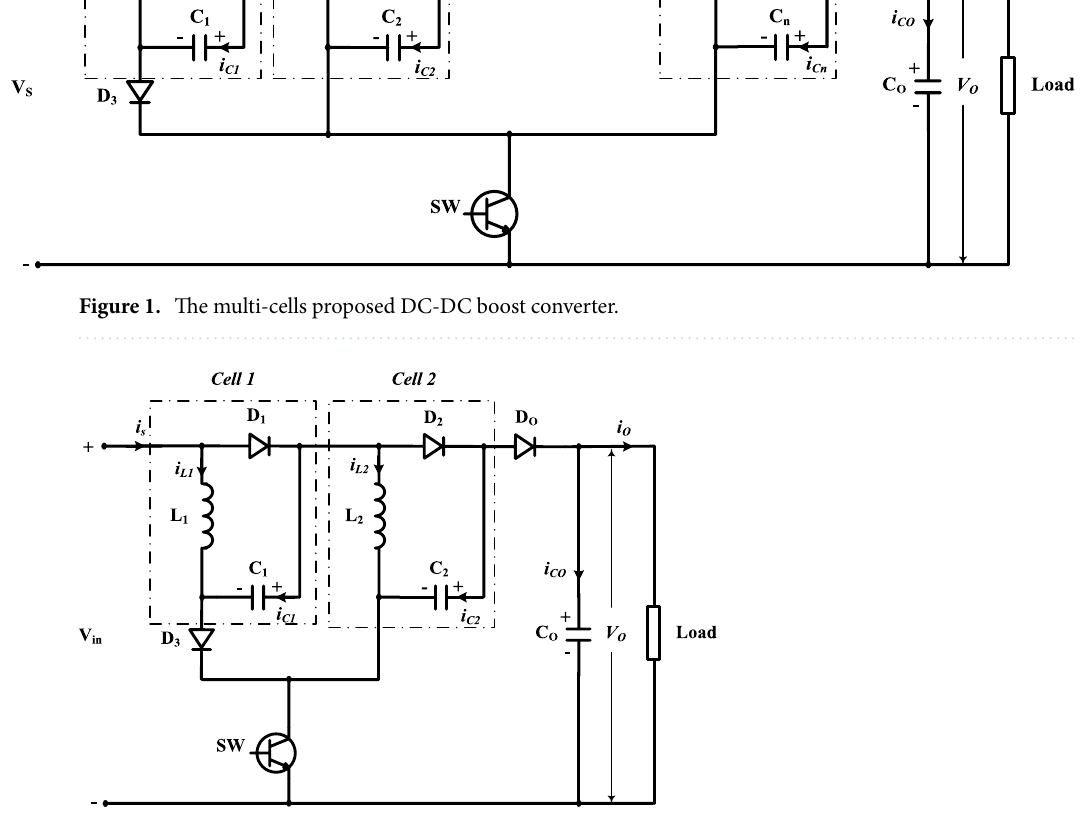
Figure 2. The two cells proposed DC-DC boost